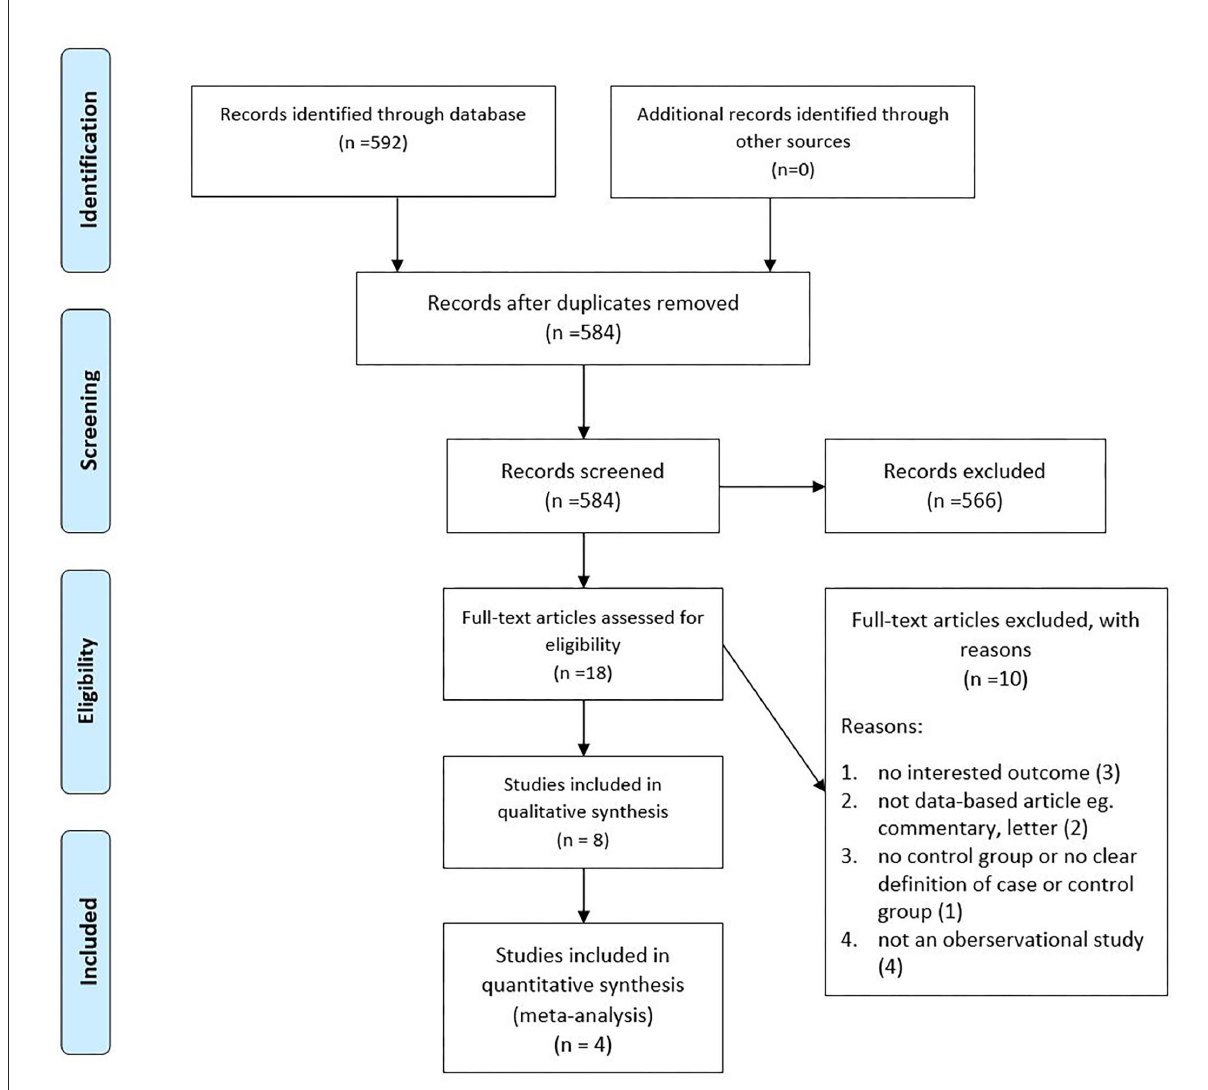
FIGURE1 PRISMA flow diagram of included